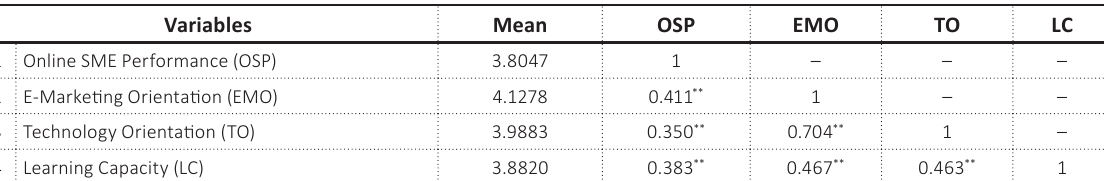
Table 2. Correlation analysis